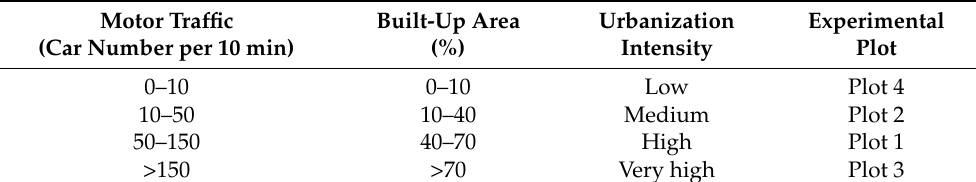
Table 1. Urbanization intensity evaluated on the basis of built-up area and traffic volume.